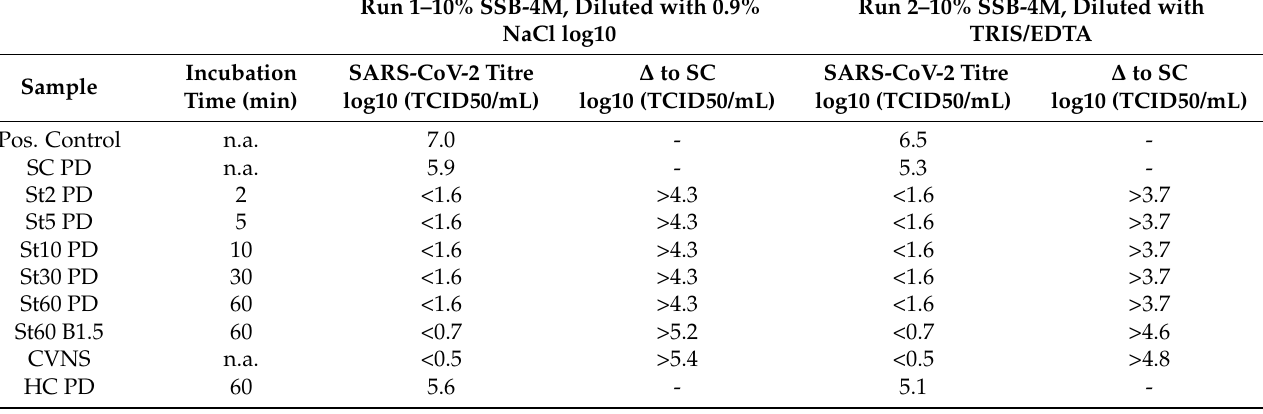
Table 4. Inactivation kinetics of SSB-4M concerning SARS-CoV-2. SSB-4M was diluted to 1:10 with 0.9% NaCl (Run 1) or TRIS/EDTA buffer (Run 2) and spiked at a ratio of 1:11 with SARS- CoV-2. Samples were drawn at the indicated times and immediately subjected to size-exclusion chromatography (PD, i.e., PD-10 protein-desalting columns) and titration to determine residual infectious virus (log 10 [TCID 50 /mL]; < : no residual infectivity detected). To lower the limit of detection, (i) the sample of the last kinetic sampling point (60 min) was diluted (1:10E1.5) and subjected to ‘bulk titration’ (sample St60 B1.5), and (ii) the cumulative volume of successive negative samples (CVNS) was taken into account. Spike control (SC PD) and hold control (HC PD) samples were derived from a separate vessel containing the respective